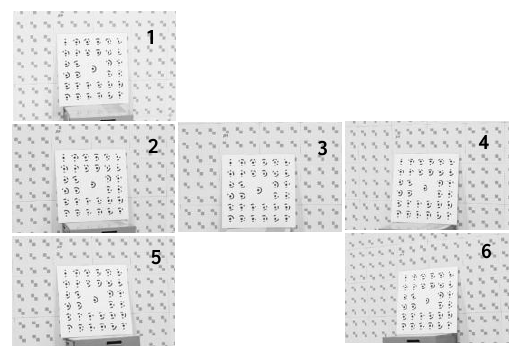
Figure 5. Six multi-intersection images